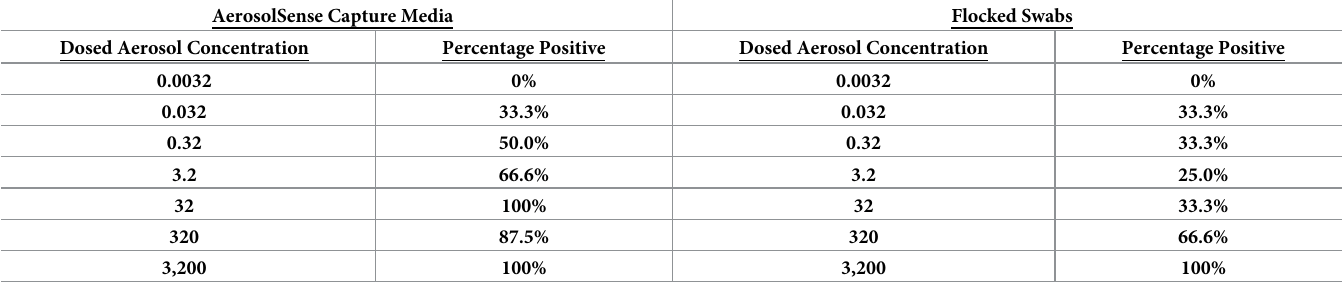
Table 5. Percent of media tested positive for the presence of SARS-CoV-2 RNA expressed as genome copied dosed per L of chamber air. AerosolSense Capture Media Dosed Aerosol